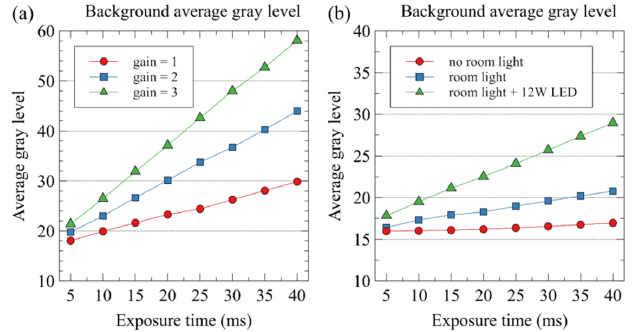
Figure 4. Sensitivity evaluation of the system ( a ) Color image of ICG solution ( b ) NIR image of ICG solution ( c ) Average fluorescence intensity from various concentrations of ICG and exposure times.